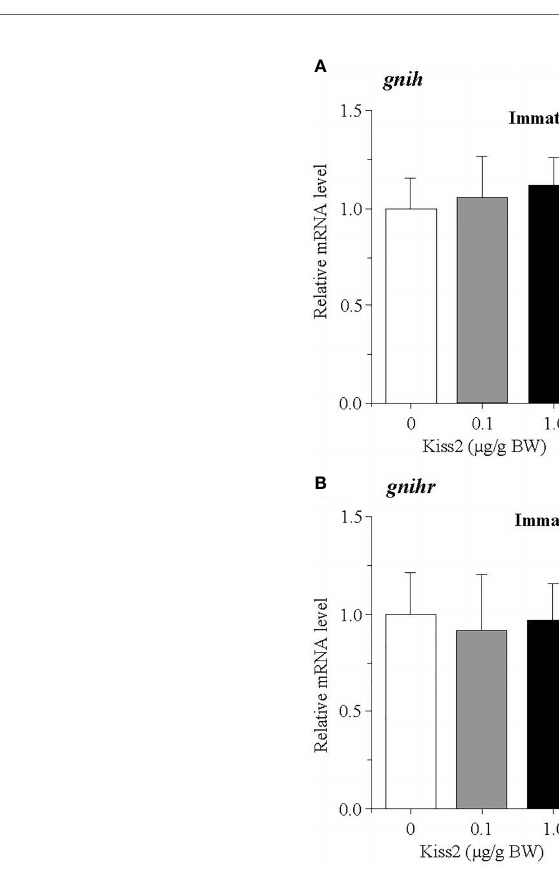
FIGURE 2 | Changes in the relative mRNA levels of gnih (A) and gnihr (B) in the brain of grass puffer at immature and mature stages after intraperitoneal injection of gpKiss2 for the period of 12hrs. Values are presented as mean ± SEM (n = 6 −